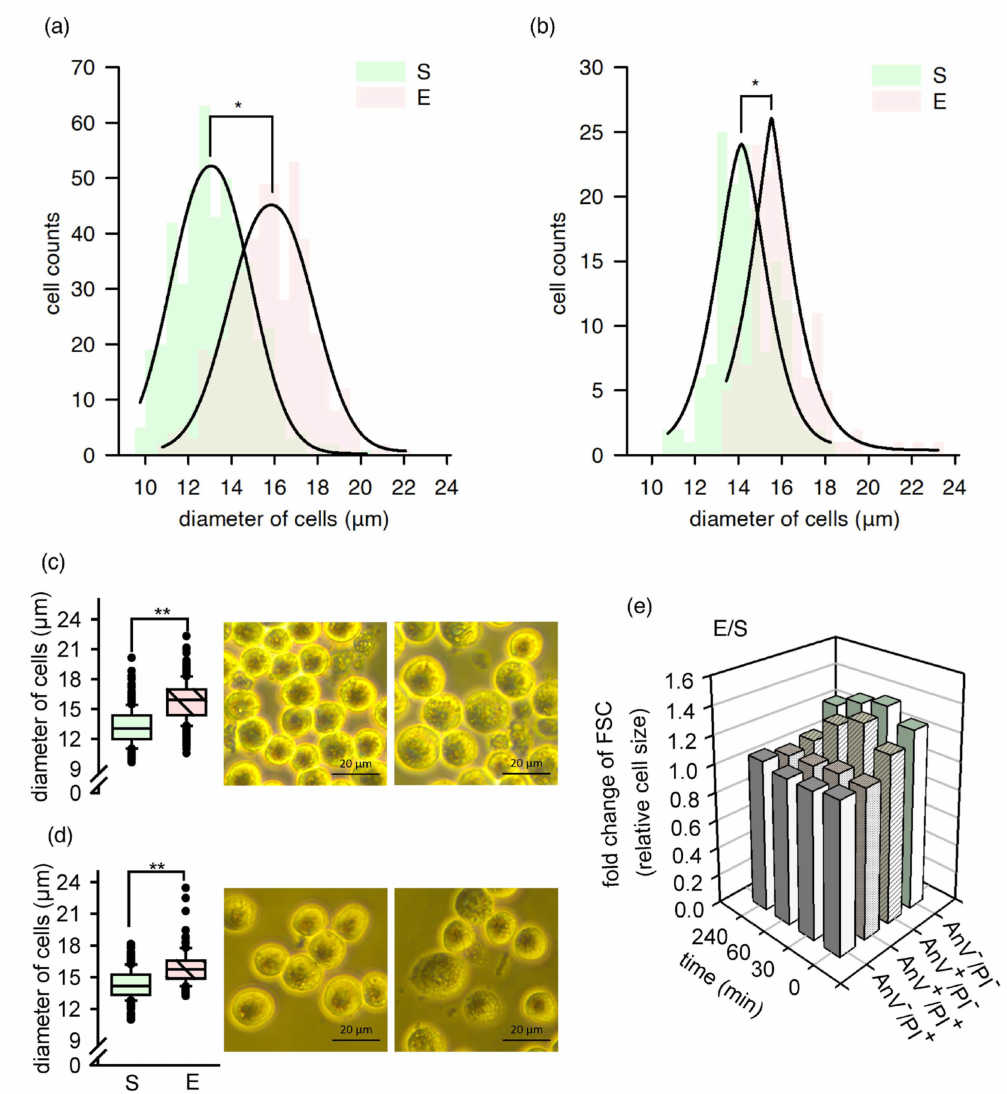
Figure 1. The increase in the size of the TM3 cells due to nsPEF treatment. S: sham-exposed cells. E: nsPEF-exposed cells. ( a ) Cell diameter distribution within the samples S and E in three independent experiments, with a total of 450 cells scored for each type of sample. The data were collected 5 min after the treatment. ( b ) Cell diameter distribution within the samples S and E in one independent experiment, with 150 cells scored for each sample. The data were collected 240 min after the treatment. ( a , b ) The solid line shows the Gaussian regression for the given data. ( c , d ) The cells’ diameter in samples S and E displayed as box plots (a median value, box: 25th and 75th percentiles (bottom and top of the boxes). Whiskers: 5th and 95th percentiles) together with the corresponding images of cells recorded using the inverted optical microscope. The data corresponds to plots ( a , b ), respectively. ( e ) The fold change of forward scatter (FSC) (relative size) of nsPEF-exposed cells after the Annexin V-Alexa Fluor 488 and propidium iodide staining compared to the sham-exposed cells stained as above. The FSC signals were recorded at 0, 30, 60, and 240 min after nsPEF exposure with flow cytometry. The independent experiments were performed five (at 0 min), three (at 30 min), and two (at 60 and 240 min) times. Standard deviations for the values in the graph have been presented separately (Table S1) to ensure data legibility. The asterisk represents the significant difference: * p < 0.0001 in the Kolmogorov–Smirnov test, and ** p < 0.001 in the Student’s t -test, between the sham and exposed